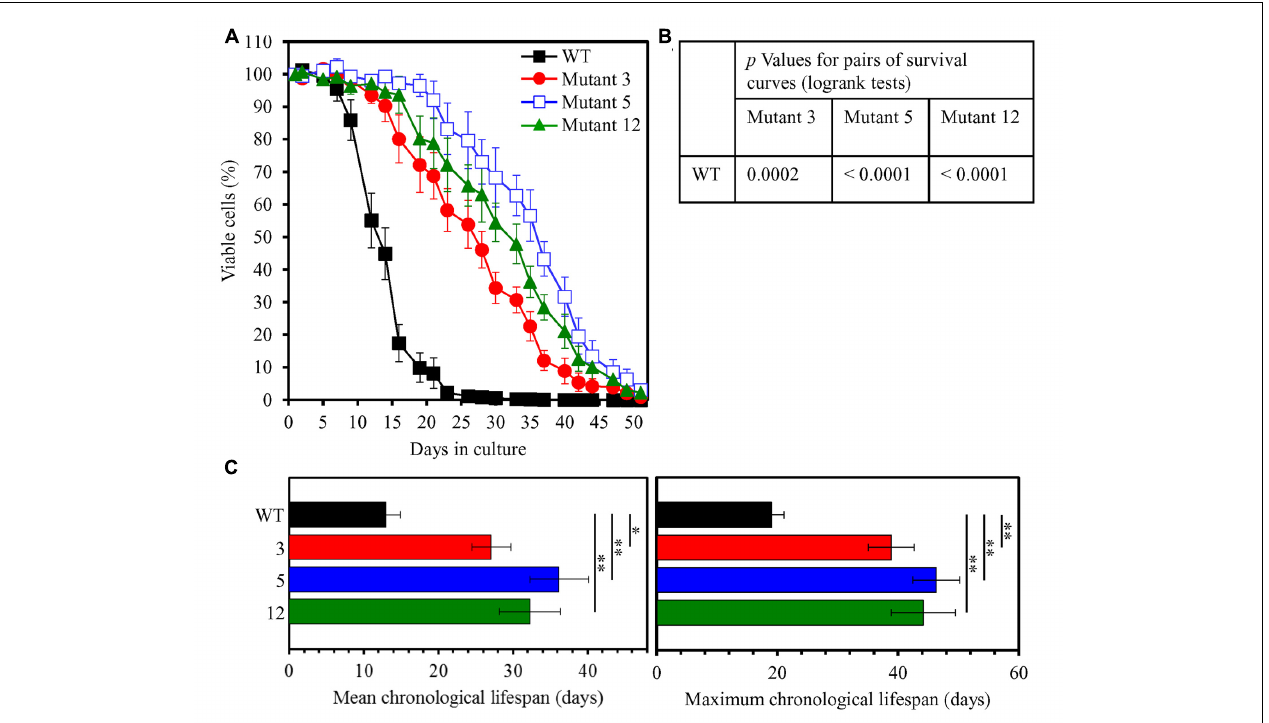
FIGURE 4 | The selected long-lived yeast species 3, 5, and 12 maintain their ability to live much longer than WT following five successive passages in medium lacking LCA. Long-lived mutants 3, 5, and 12 underwent five consecutive passages in liquid medium without LCA. Each of them was then inoculated into liquid YP medium lacking LCA and initially containing 0.2% glucose. (A) Survival curves of chronologically aging WT and long-lived mutant strains cultured in this medium are shown. Data are presented as means ± SEM ( n = 3). (B) p Values for pairs of survival curves of the WT and mutant strains. Survival curves shown in (A) were compared. The survival curve for the WT strain was considered statistically different from the survival curve for the mutant strain if the p value was less than 0.05. The p values for comparing pairs of survival curves using the log-rank test were calculated as described in Section “Materials and Methods.” (C) Survival curves shown in (A) were used to calculate the mean and maximum chronological lifespans for WT and mutant strains. Data are presented as means ± SEM ( n = 3; ∗ p < 0.05; ∗∗ p < 0.01).